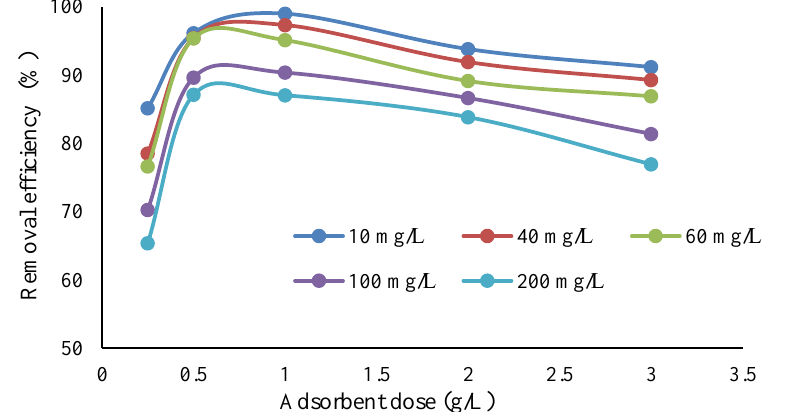
Fig. 7. Effect of adsorbent dose on removal efficiency using EDTA and chitosan- modified MWCNT (pH: 7, contact time: 60 min, dye content: 60